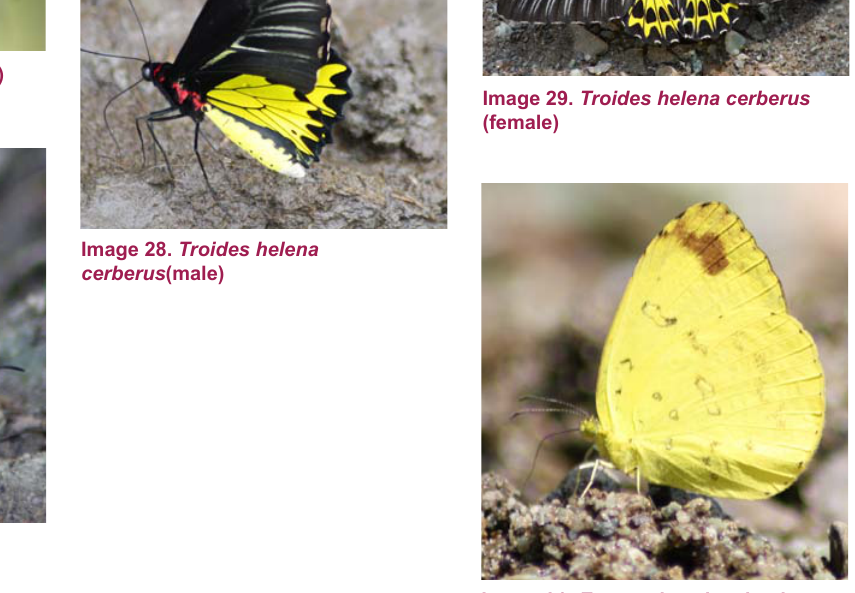
Image 31. Eurema hecabe simulata